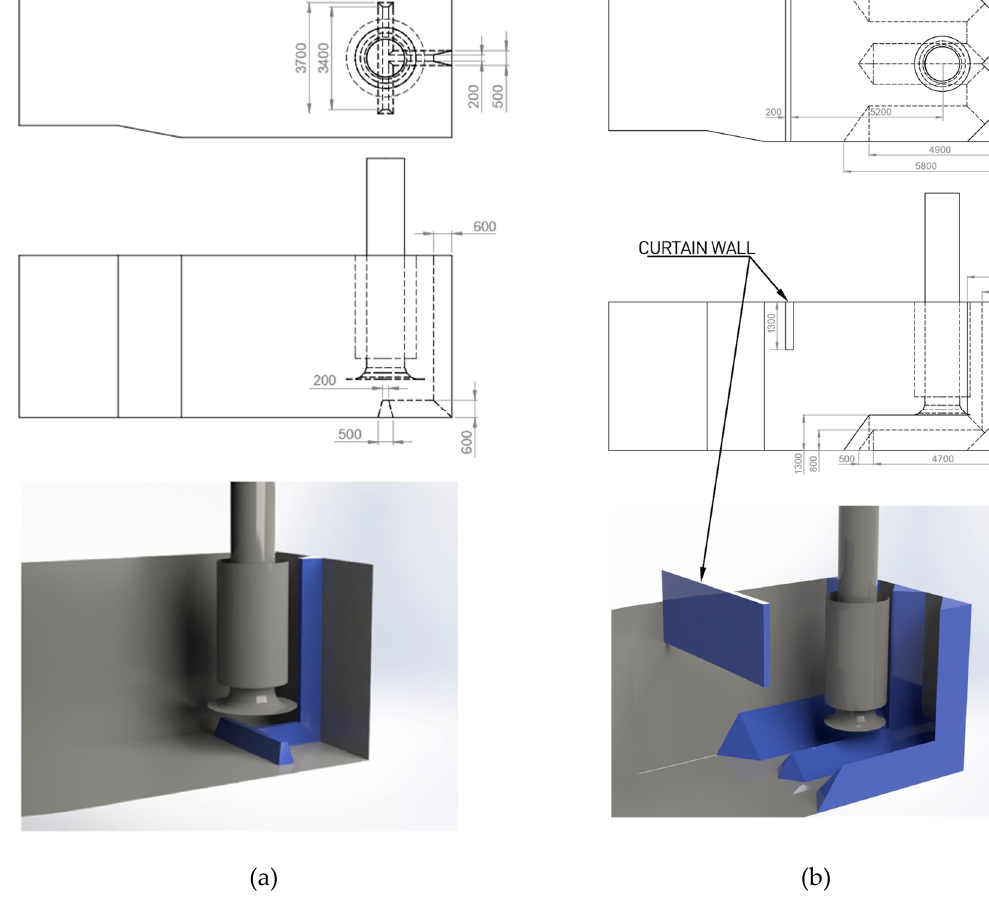
Figure 18. Proposed fillet-splitter design to reduce vortex formation: ( a ) trapezoidal-shaped cross floor baffle with vertical backwall splitter; ( b ) trident-shaped triangular floor baffle and 45° corner fillets.